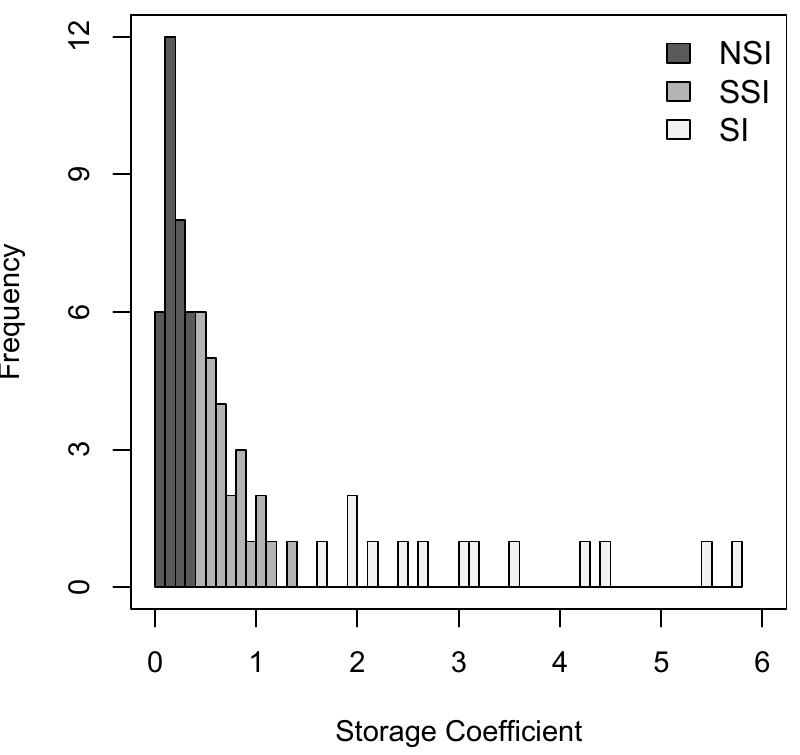
Figure 5. Distribution of estimated storage coefficients using the ∆ℎ and ∆𝑉 time series. Note that NSI storage coefficients are 0–0.4, SSI storage coefficients are 0.4–1.5, and SI storage coefficients are >1.5. Table 2. Eleven basins showing ∆ t > 10 yrs and either SI or SSI ( S > 0.4), ordered from highest to lowest estimated S . FSI Depth is interpreted from Figure 54 in Williams and Kuniansky